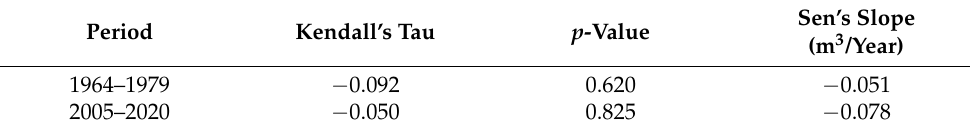
Table 4. Mann-Kendall and Sen’s slope test results for streamflow